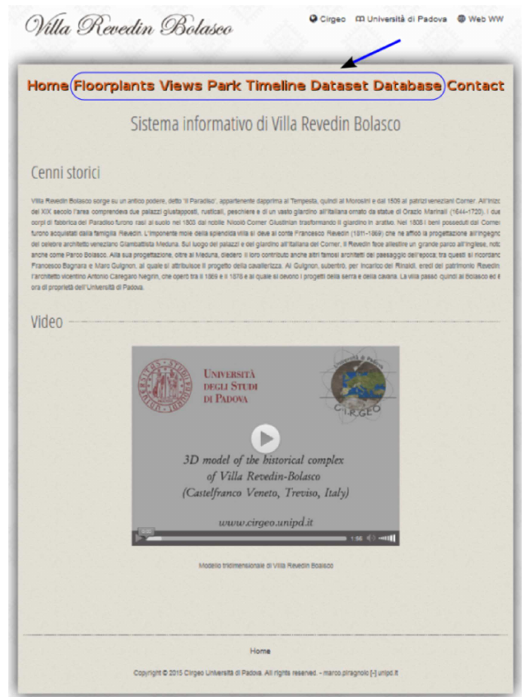
Figure 8. Home page of Web-GIS of Villa Revedin Bolasco. The blue area highlights the main tabs.